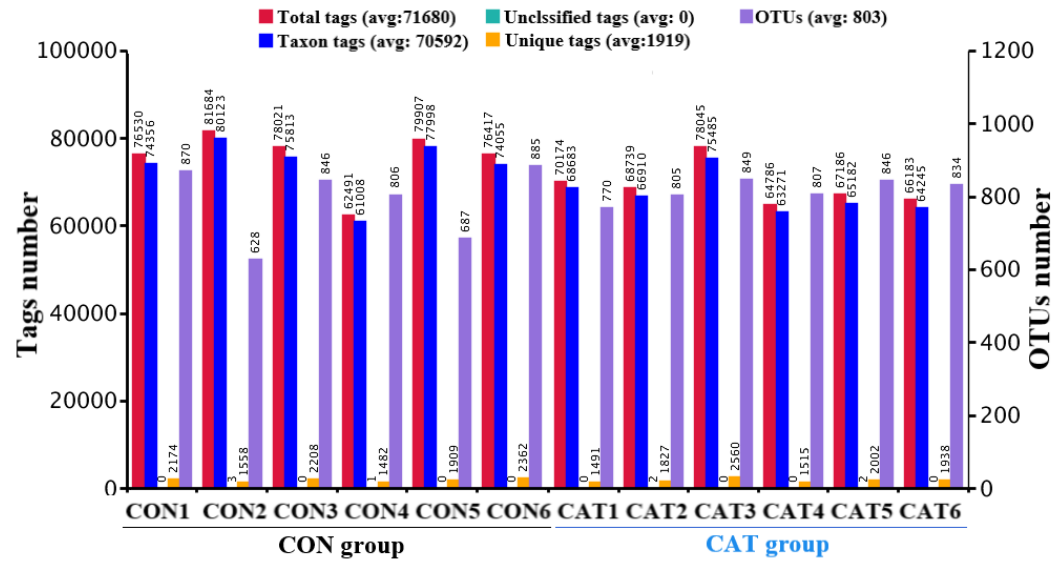
Figure 1. Operational taxonomic unit (OTU) clustering and annotation per sample. CON 1, 2, 3, 4, 5, and 6 are colonic digesta samples from piglets fed with a basal diet; CAT 1, 2, 3, 4, 5, and 6 are colonic digesta samples from piglets fed with a basal diet supplemented with 2.0 g / kg exogenous catalase production.